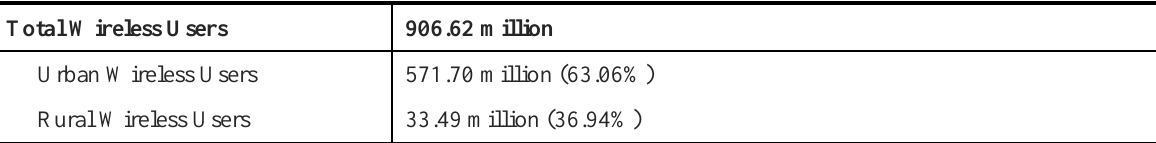
Table 1: Total wireless users and tele-density in India with urban and rural distribution as of September